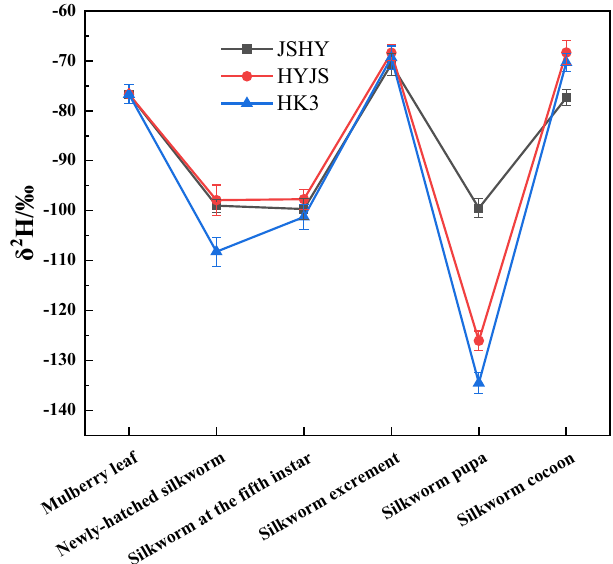
Figure 3. Line chart of hydrogen stable isotope ratios in samples.